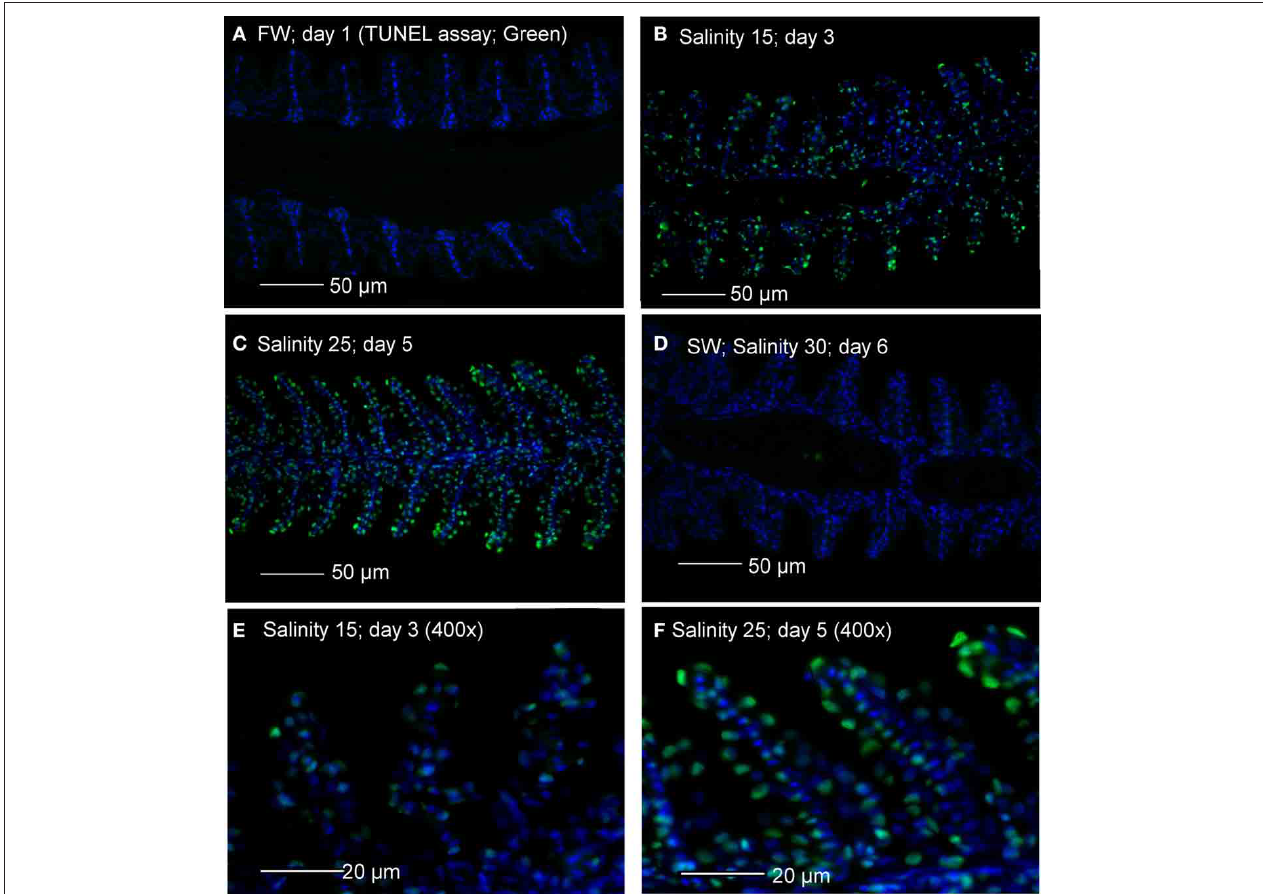
FIGURE 1 | Apoptotic cells indicated by TUNEL-positive nuclei (green) in gill sections of Anabas testudineus kept in (A) freshwater on day 1 (FW; control), or after 24h of exposure to (B) salinity 15 on day 3, (C) salinity 25 on day 5 or (D) salinity 30 on day 6 after a progressive increase in salinity. All sections